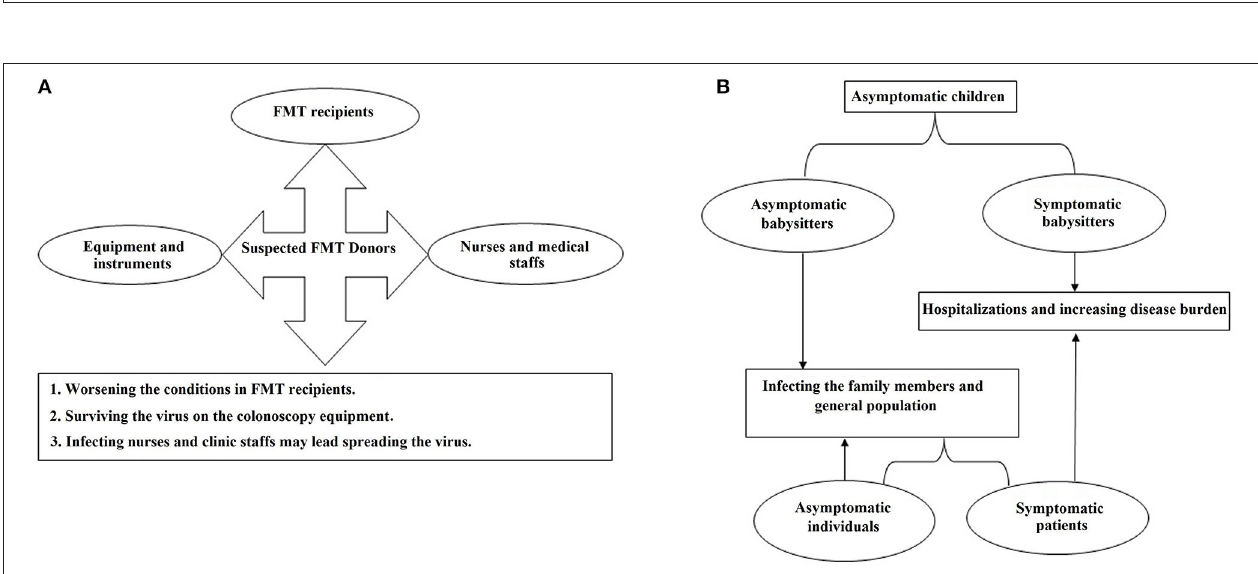
FIGURE 2 | The flowcharts of the probable distribution scenarios for COVID-19 which may happen in (A) gastroenterology clinics and (B) primary schools and kindergartens.